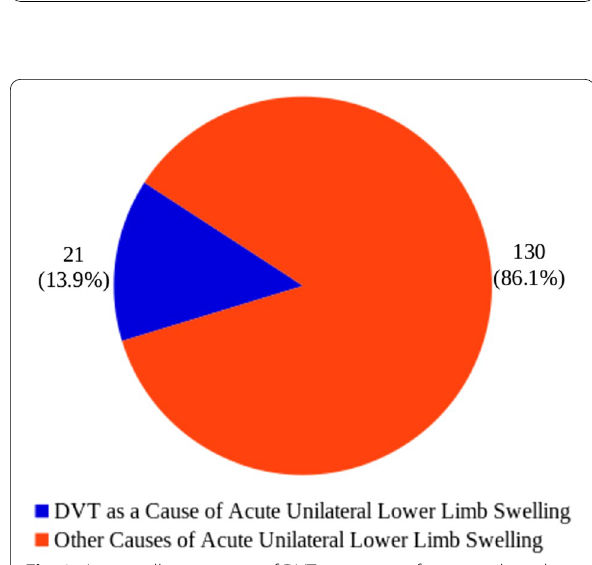
Fig. 2 An overall assessment of DVT as a cause of acute unilateral lower limb swelling versus other